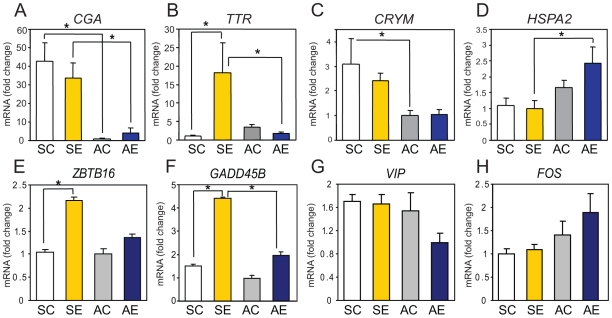
Validation of microarray results by real-time PCR.Expression of A) glycoprotein hormone alpha chain precursor (CGA), B) transthyretin (TTR), C) μ-Crystallin (CRYM), D) heat shock 70 KDa protein (HSPA2), E) zinc finger and BTB domain containing 16 (ZBTB16), F) growth arrest and DNA-damage-inducible, beta (GADD45B), G) vasoactive intestinal peptide (VIP), and H) c-fos (FOS) were determined. Results were calculated in relative RNA amounts using β-actin (ACTB) as internal control and shown as mean fold-change to group with lowest expression value. n = 5−7/group, * p<0.05 by ANOVA followed by Tukey's test as posthoc pair-wise comparisons. Results are shown in mean±SEM.